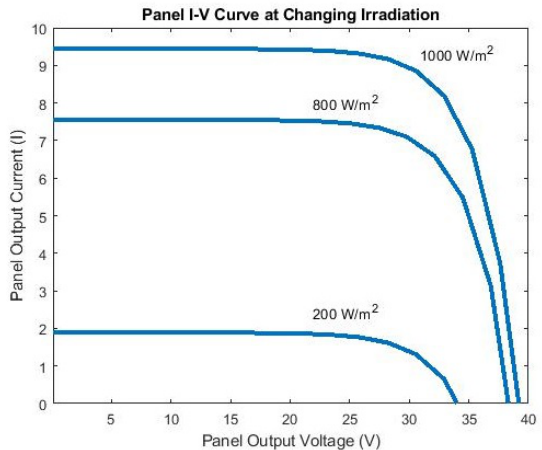
Figure 5. I-V characteristic under changing irradiation.